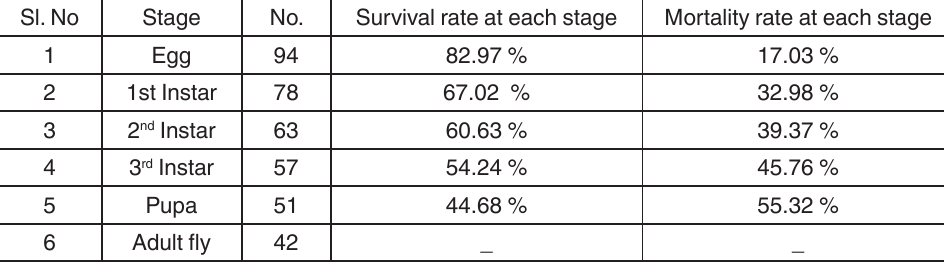
table 1. Survival rate of different life stages of H. ligurriens in Kerala, India Sl. No